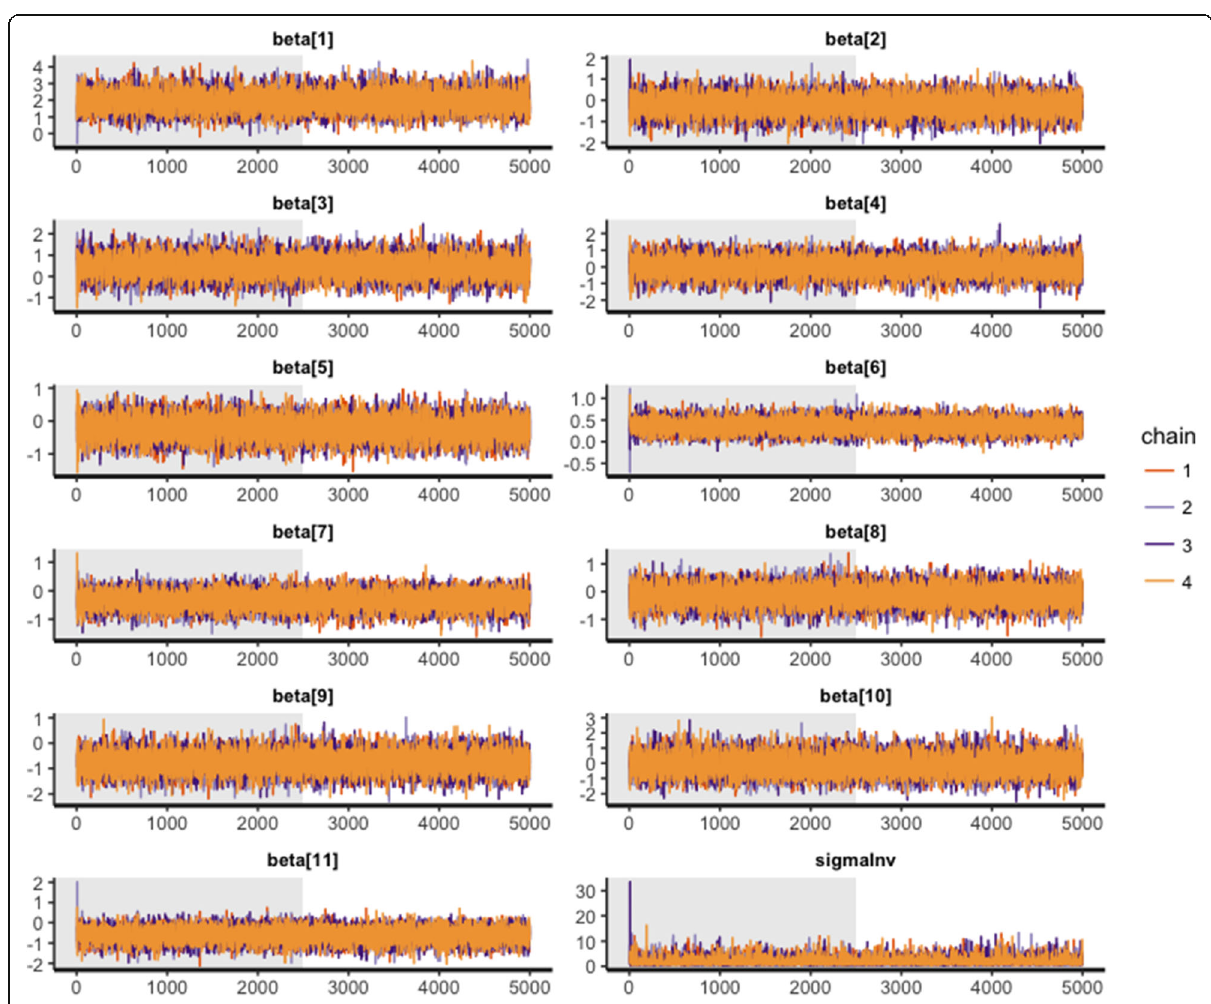
Fig. 6 Trace plots for the instructor analysis. The beta parameters (1 – 11) correspond to the regression coefficient of the intercept, tenured faculty, lecturers, GTAs, females, reports of student-centered practices, success perception, 60 – 80% of students prepared, 40 – 60% of students prepared, and <40% of students prepared, respectively. The grayed iterations indicate those iterations that were removed from the analysis for burn-in. None of the plots suggest problems with convergence of the Markov